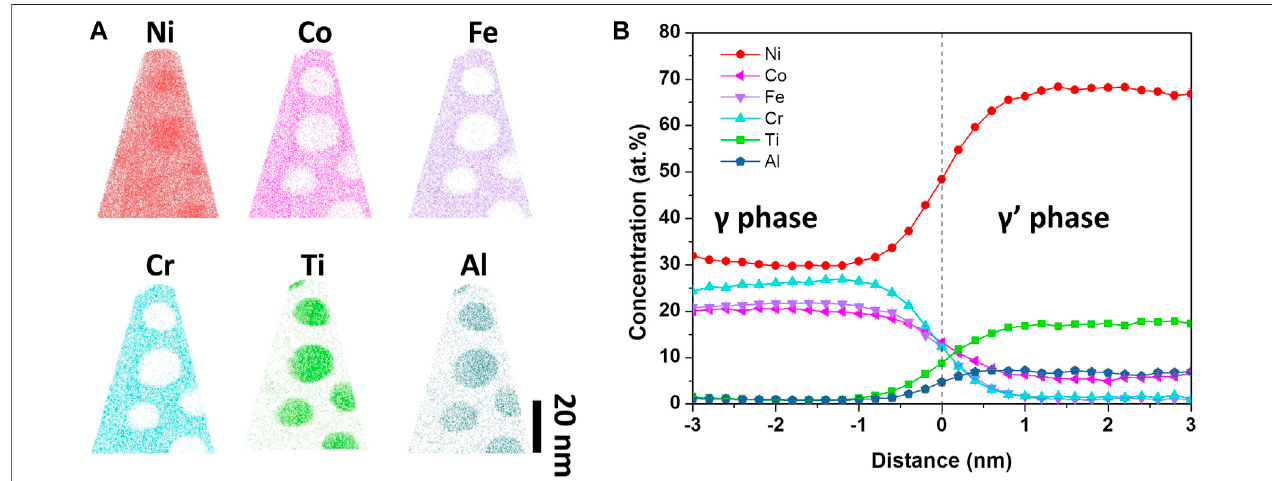
FIGURE 2 | (A) The atom maps of Ni, Co, Fe, Cr, Ti, and Al of the alloy Ni 2 CoFeCrTi 2 Al 1 . (B) The Proximity histogram of concentration pro fi les of the γ ′ nanoparticles.